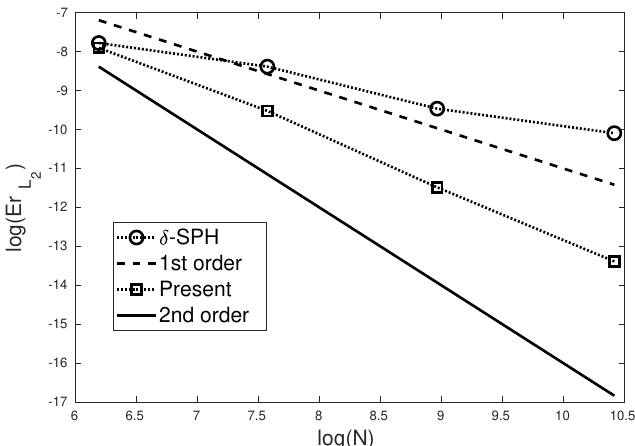
Figure 13. Oscillating droplet under a central conservative force field: Convergence studies with present SPH and δ -SPH [23] schemes. The dotted line with small circles denotes the convergence curve of the δ -SPH scheme and the dotted line with small squares denotes the convergence curve of the present SPH model. The dashed and continues lines represent 1st and 2nd order of convergence slops,